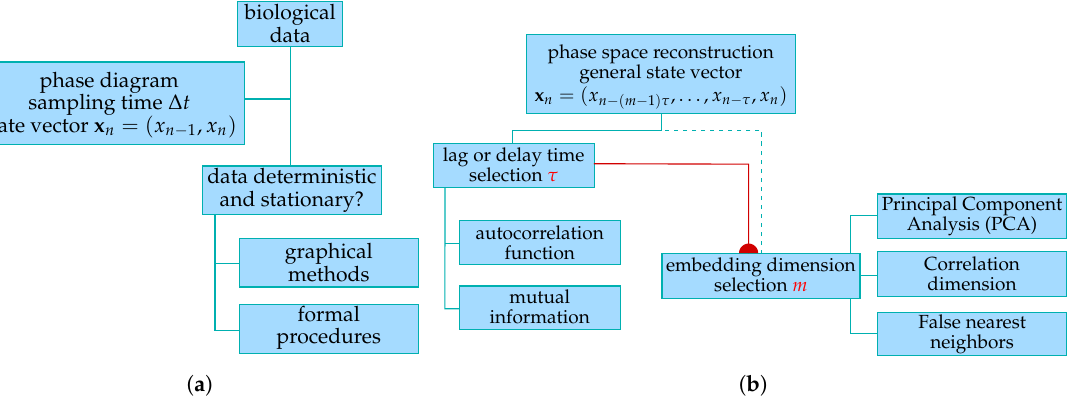
Figure 2. From a sequence of scalar measurements: ( a ) data and requirements; and ( b ) the reconstruction done in this paper for the PPG signal following the lag or delay method. The description of the concepts is in Section 2.2, and the application results are in Section